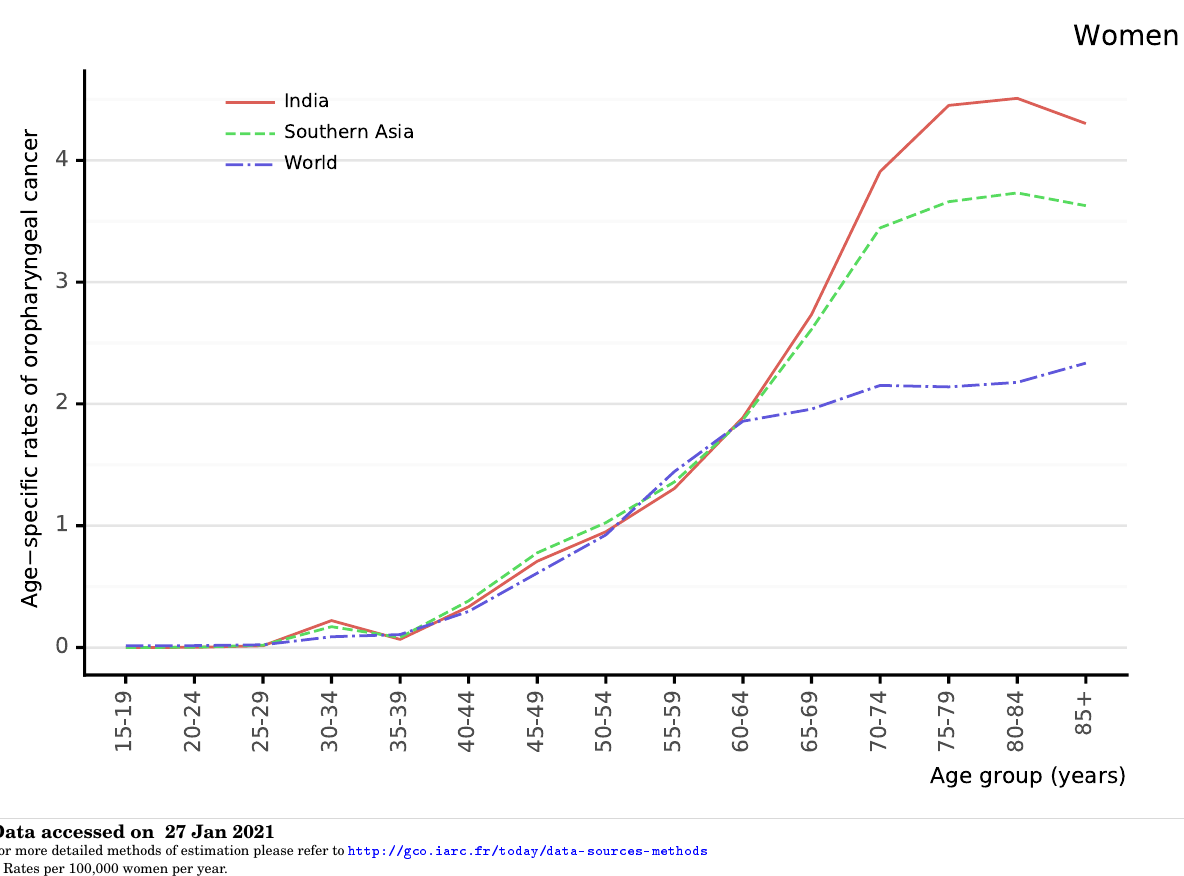
Figure 94: Comparison of age-specific oropharyngeal cancer incidence rates among women by age in India, within the region, and the rest of